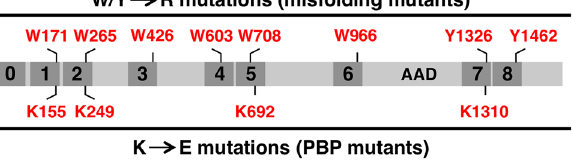
Figure 1. Schematic of TOPBP1 highlighting the BRCT domains and the AAD. We produced two panels of mutants. Misfolding mutants are shown up top and the PBP mutants are shown at the bottom.